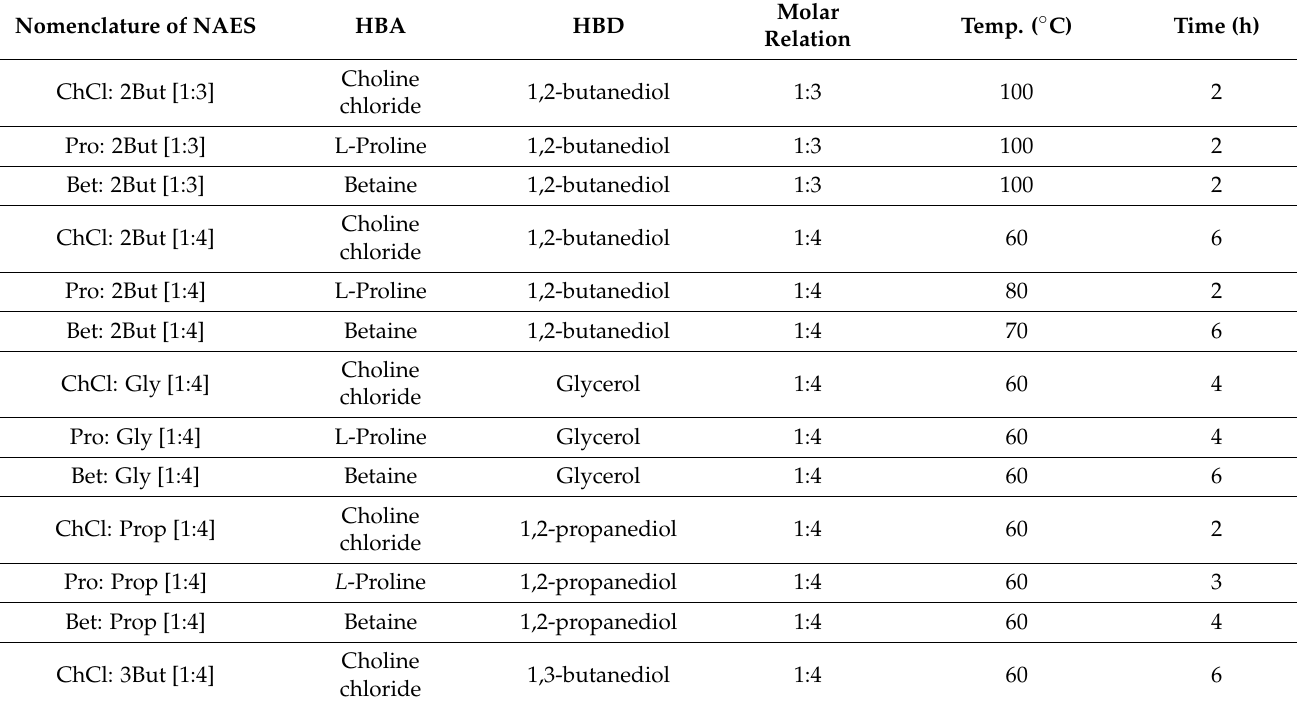
Table 1. Conditions and observations of NAES